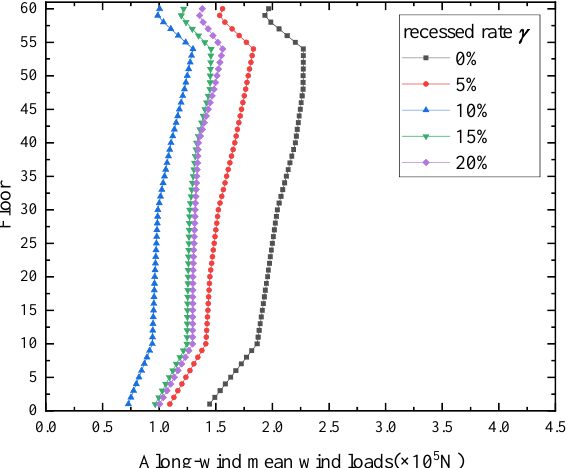
wind loads are almost zero, and the across − wind mean wind loads is not discussed in this study.